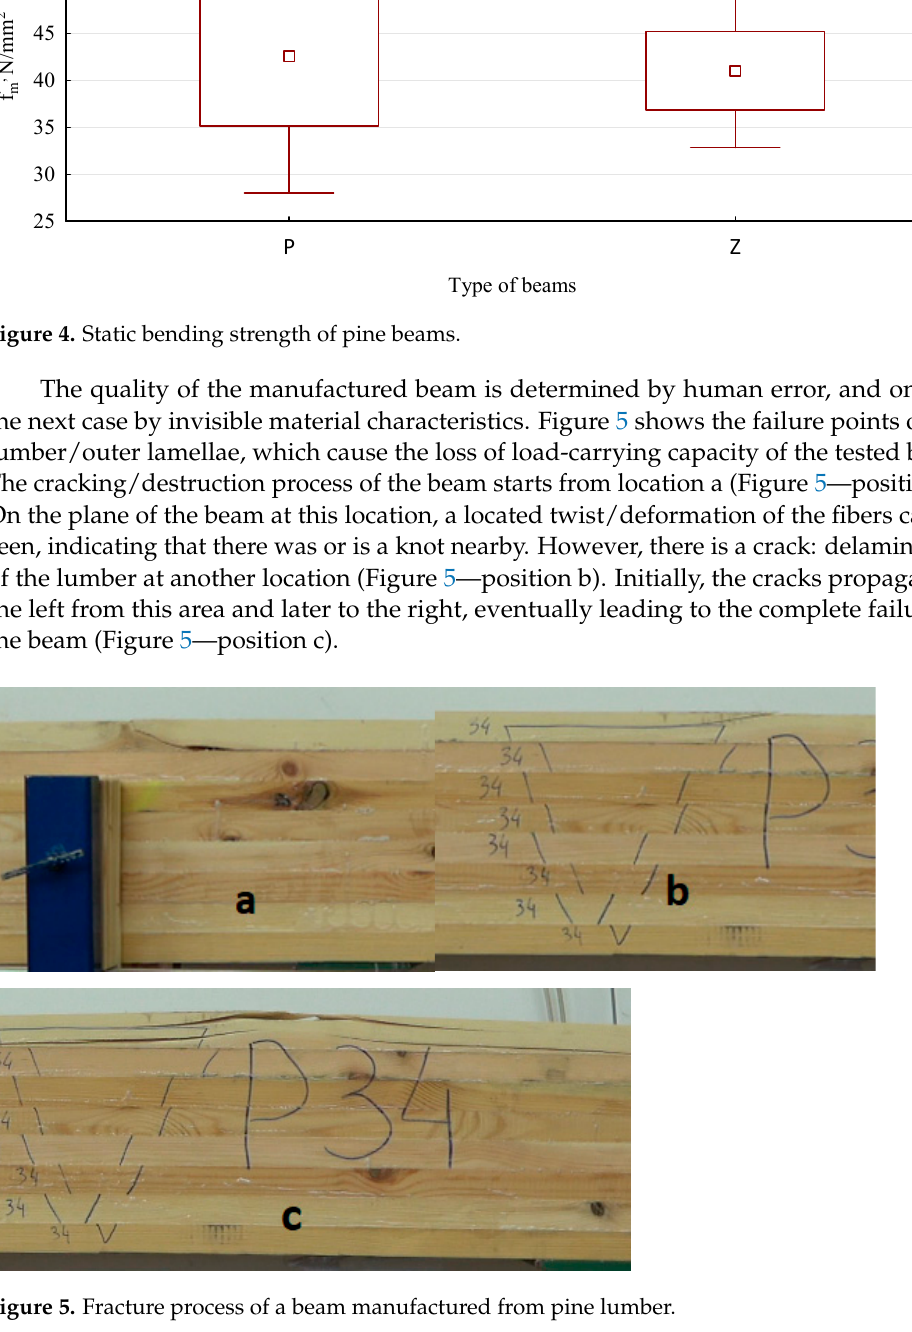
Figure 4. Static bending strength of pine beams.